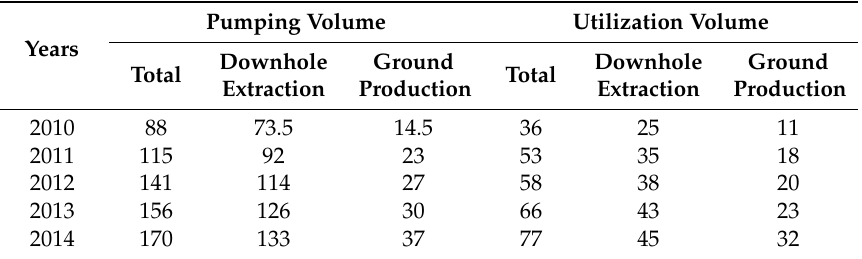
Table 1. Coalbed methane extraction and utilization in China in 2010–2014.